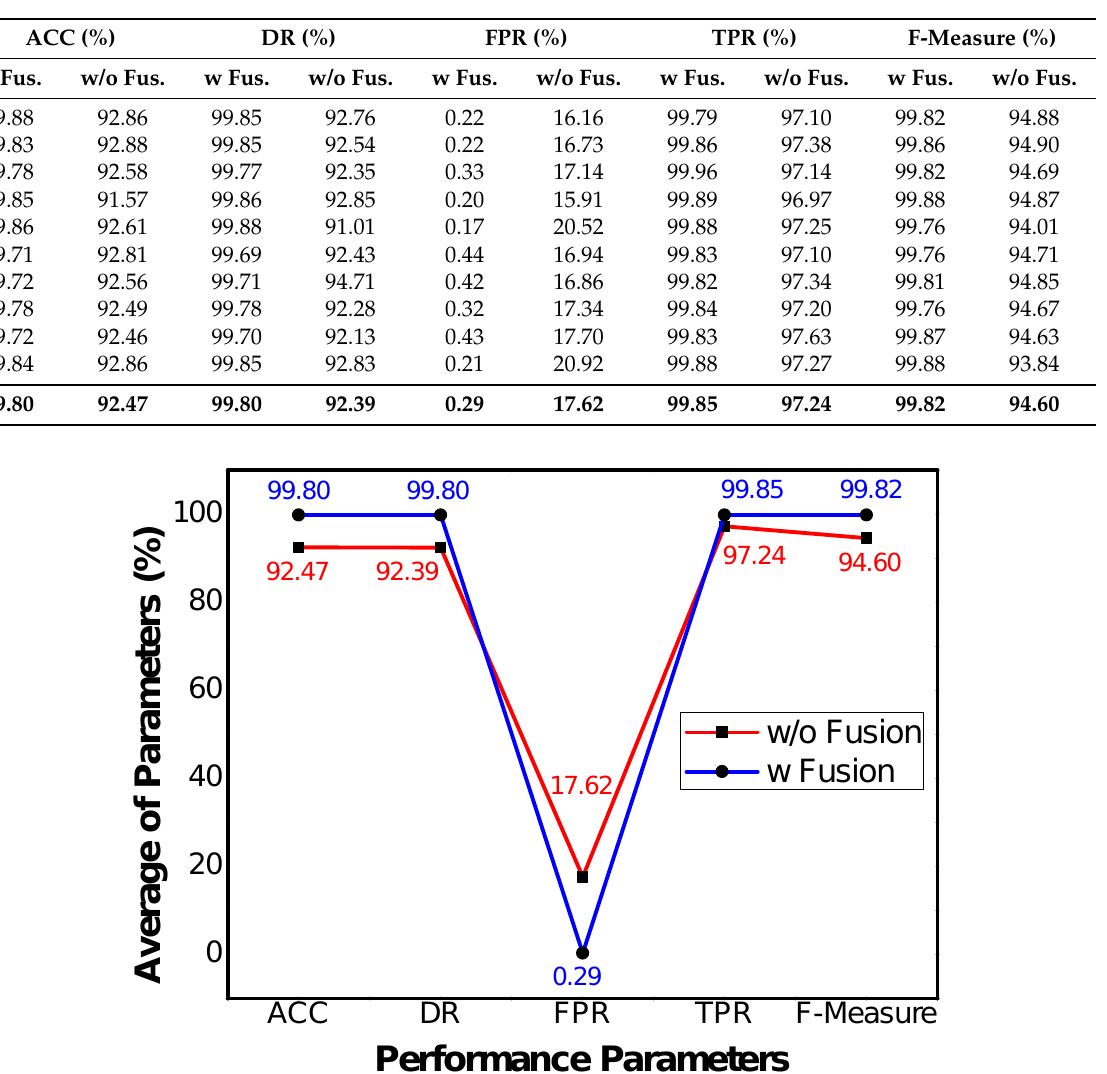
Table 5. Experimental results of evaluation parameters.